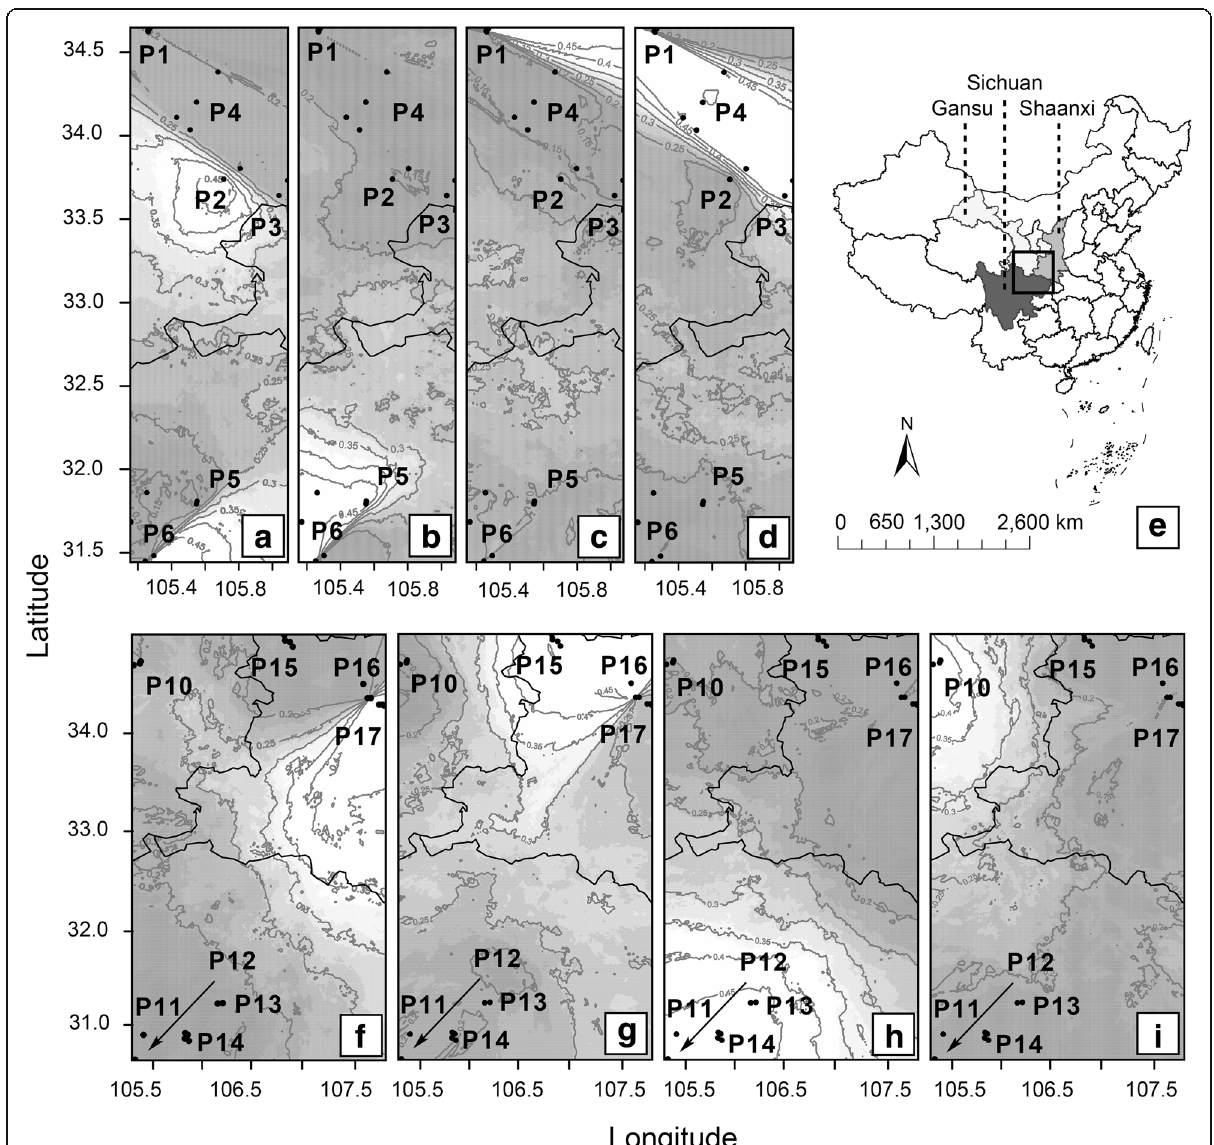
Fig. 5 Maps of the posterior probabilities of population membership inferred by Geneland. a-d Four clusters inferred by Geneland among individuals in spring 2013. e The map of study area in this study. f-i Four clusters in spring of 2014. Contour lines indicate the spatial position of the genetic discontinuities. Lighter shading indicates higher probabilities of population membership. Due to the limited space, population code (P1-P6, P10-P17) was abbreviated from GS-P1-S13, GS-P2-S13, GS-P3-S13, GS-P4-S13, SC-P5-S13, SC-P6-S13, GS-P10-S14, SC-P11-S14, SC-P12-S14,